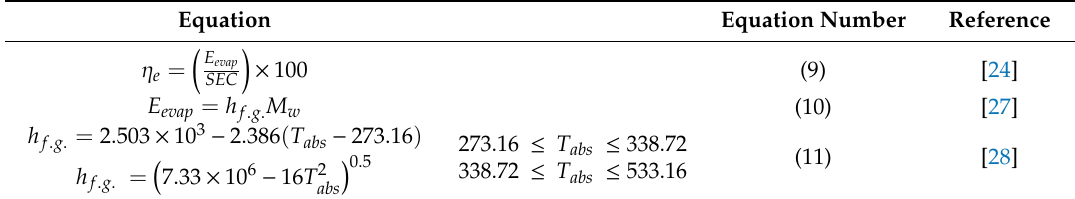
Table 3. Formulas used for determining the energy e ffi ciency of di ff erent